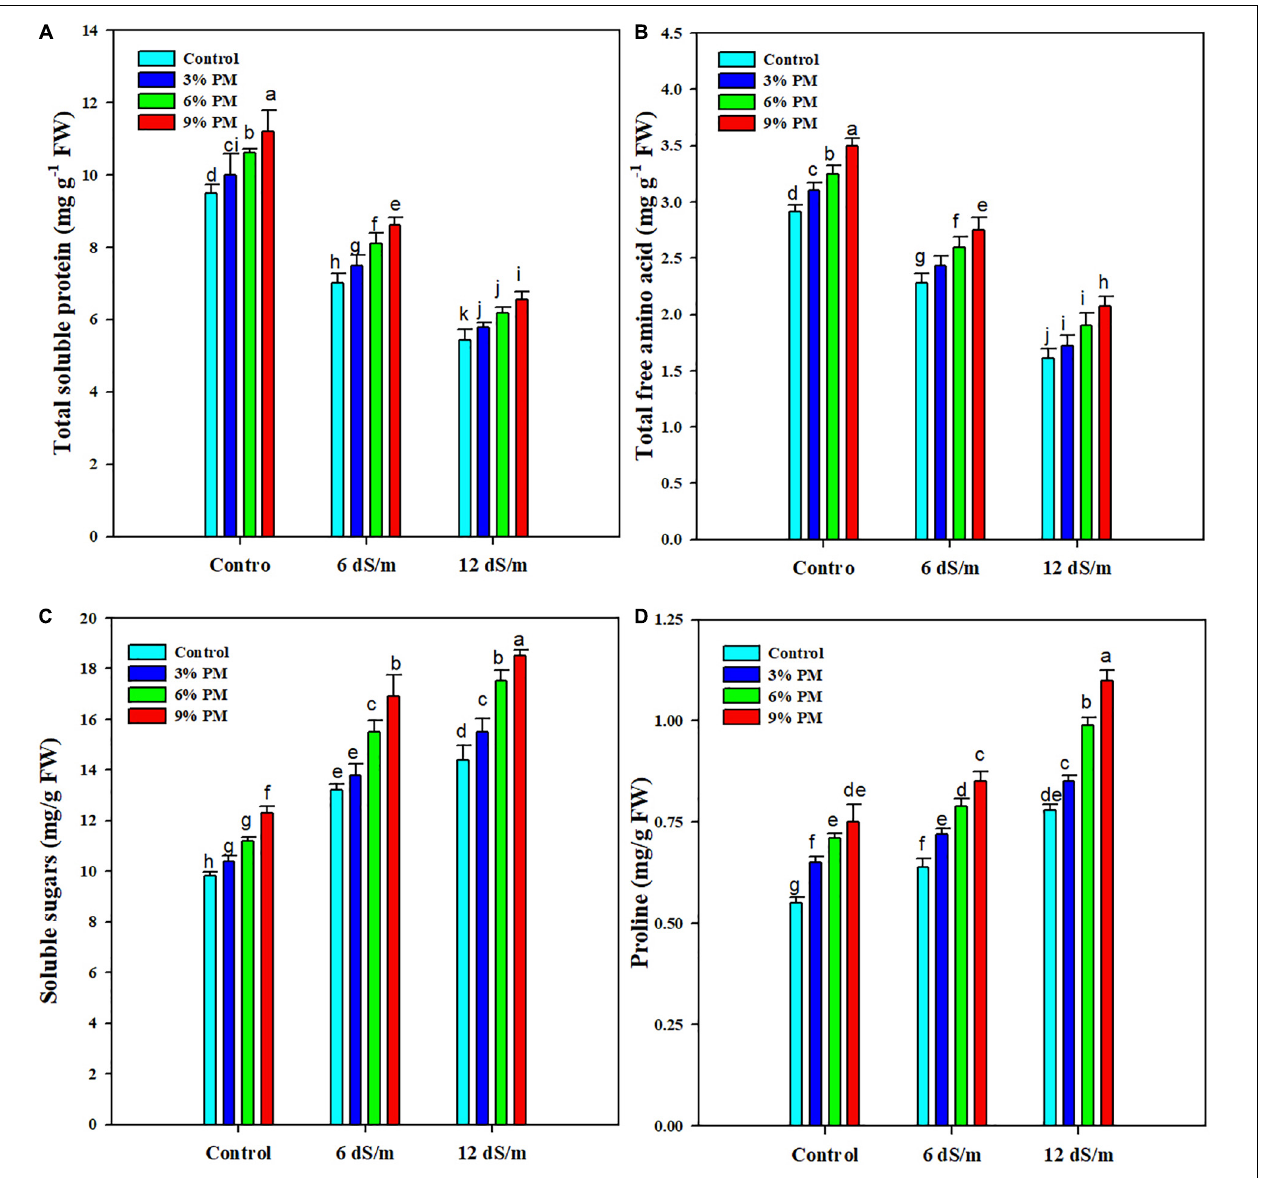
FIGURE 3 | Effect of different levels of press mud application on TSP (A) , FAA (B) , soluble sugars (C) , and proline (D) contents of rice crop grown under different levels of salinity stress. The bars indicate the means of three replications with ± S.E. and a different letter indicating significant differences at p <